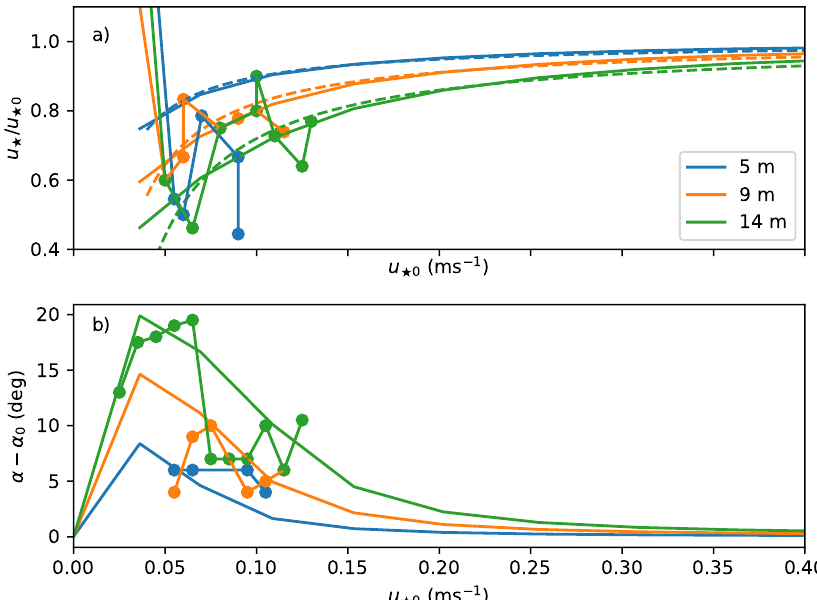
Figure 7. The ratio u (cid:63) ( z ) / u (cid:63) 0 ( a ) and the difference of the cross-isobar angle α ( z ) − α 0 ( b ) as functions of u (cid:63) 0 based on the single-column model results (solid curves) and observations (solid curves with markers). The dashed line in ( a ) corresponds to Equation (20) with b = 500 s.